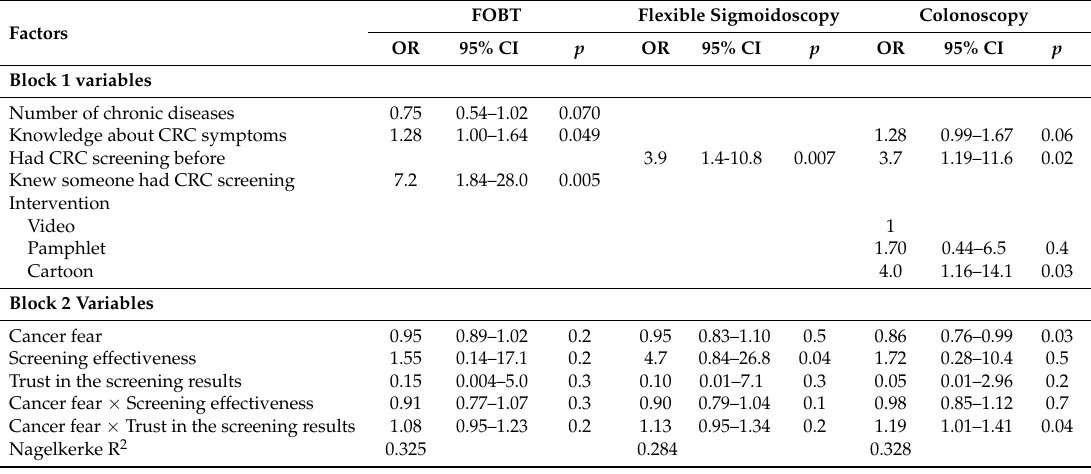
Logistic regression analysis for screening interest of FOBT, flexible sigmoidoscopy and